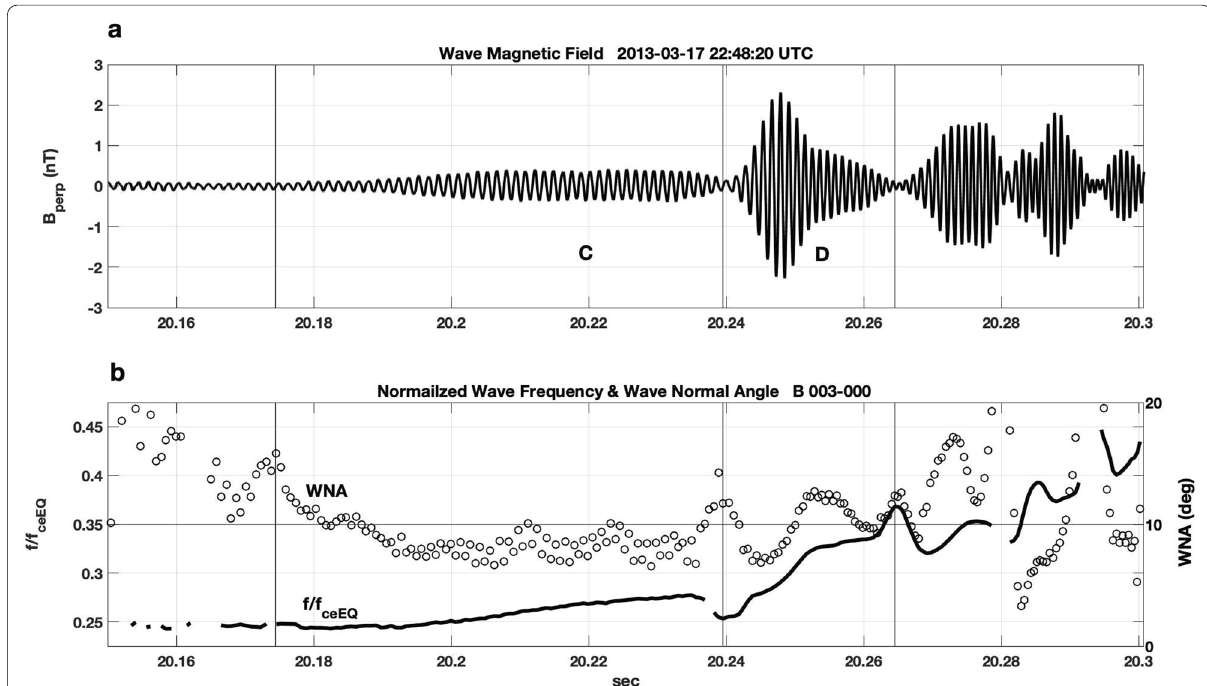
Fig. 4 Analysis of the subpacket structure for the chorus element shown in Fig. 3 is shown. a Wave magnetic field exhibits an initial gradual increase in amplitude over < 70 ms, followed by a second strong subpacket with |B perp |~ 2 nT. b Normalized wave frequency (solid line, f / f ceEQ ) and wave normal angle (open circles) are shown. Increasing wave amplitude and frequency are seen for WNA <